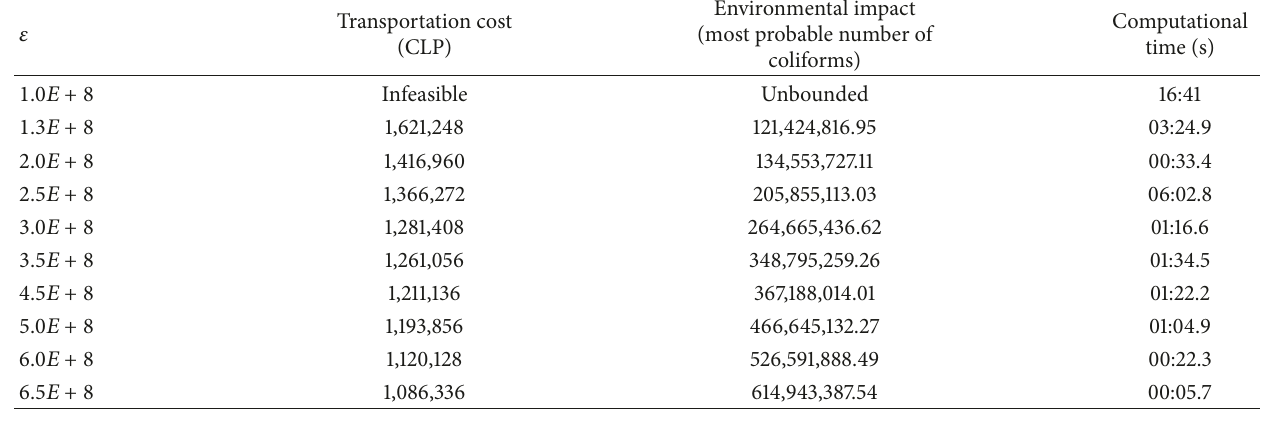
Table 5: Results of total transportation cost and environmental impact using the epsilon-constraint method.